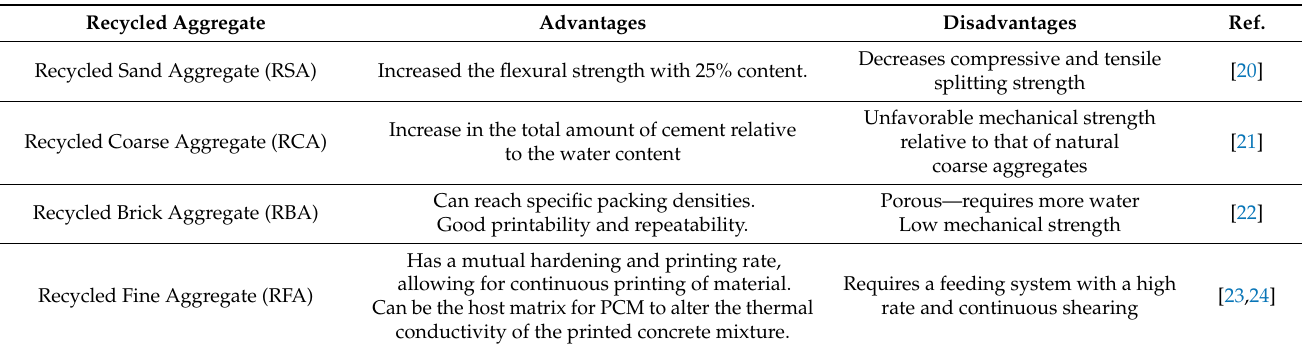
Table 1. Recycled Aggregates